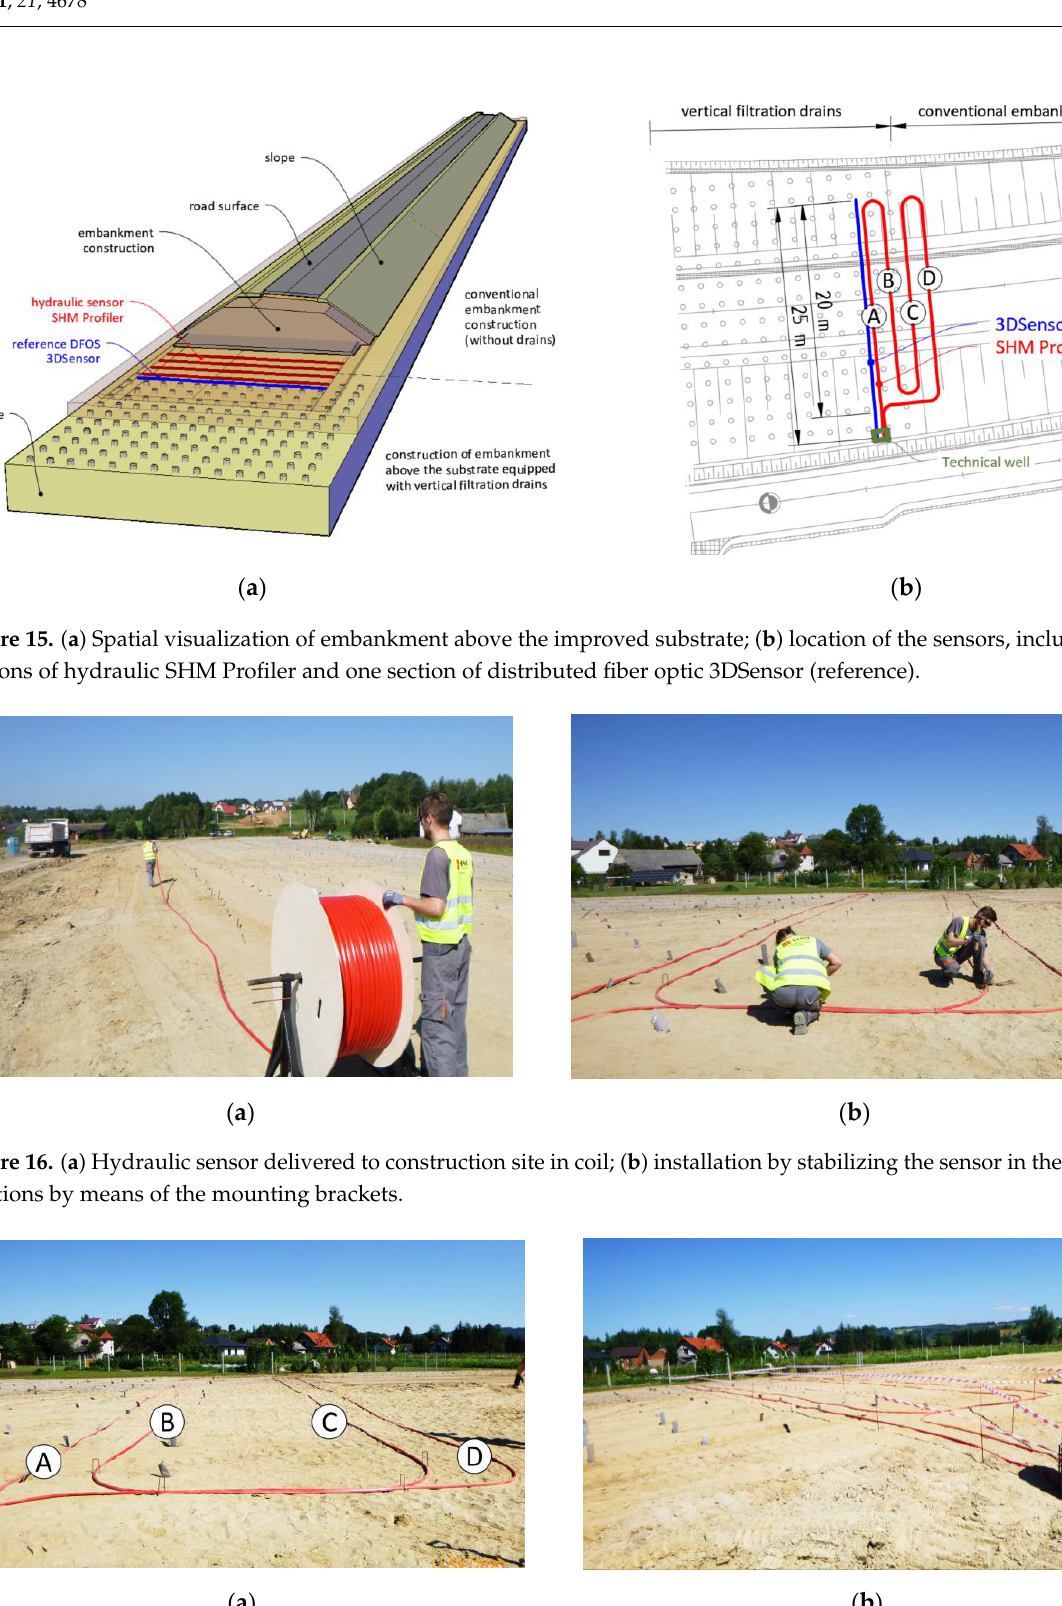
Figure 17. ( a ) The view of the construction field after installation of all the sensors; ( b ) the view of technical well protecting hydraulic tubes, pigtails, and signal wires of the sensors.